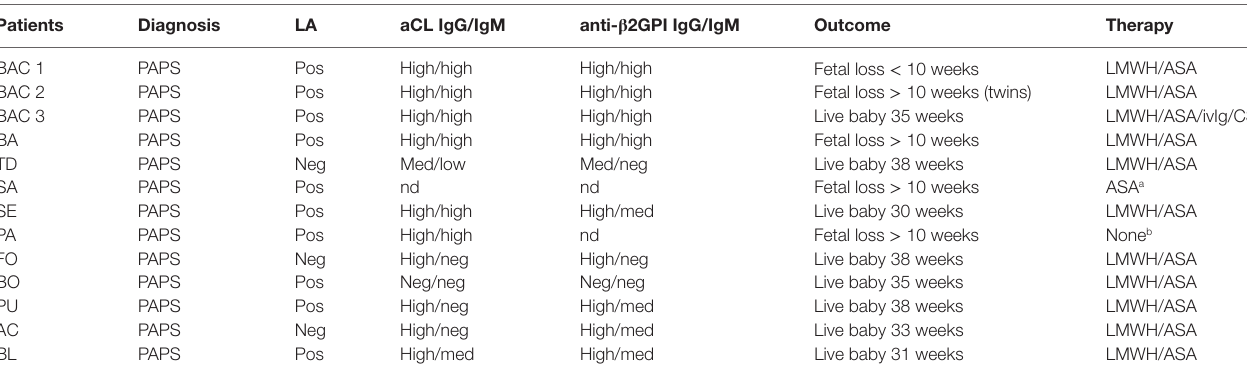
tABLe 1 | Clinical characteristics of the PAPS patients examined for placental C deposits.